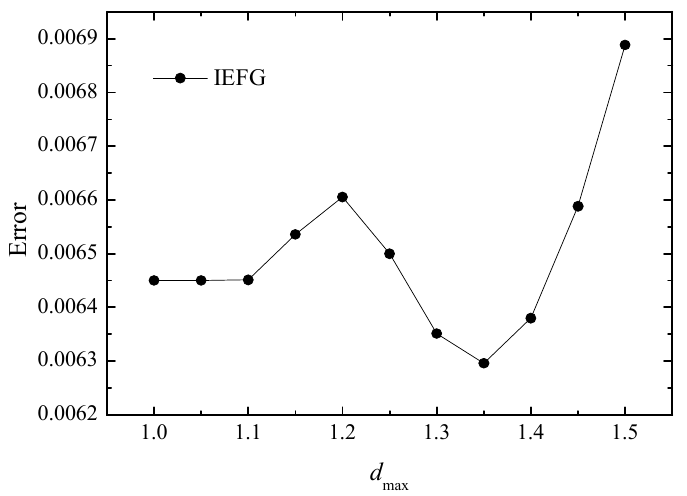
Figure 1. The error of the numerical solutions of the IEFG method with the increase in d max . (3) Penalty factor